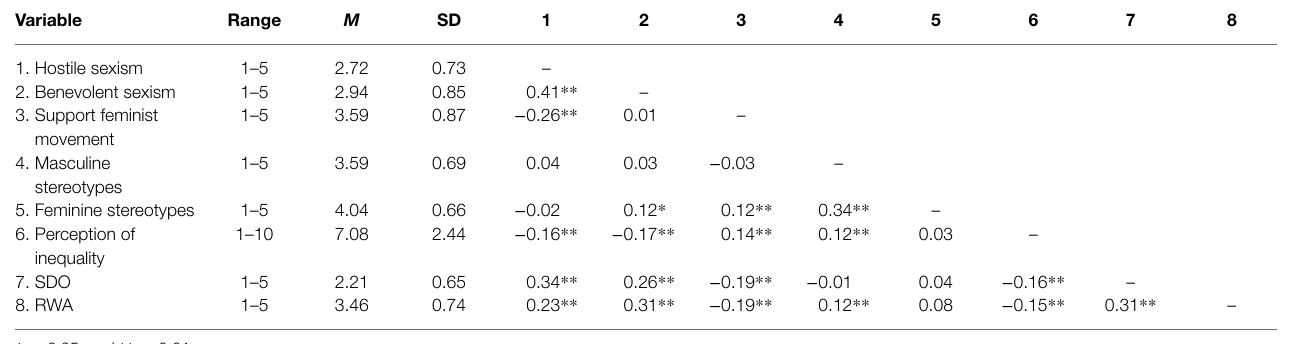
TABLE 1 | Descriptive statistics and bivariate